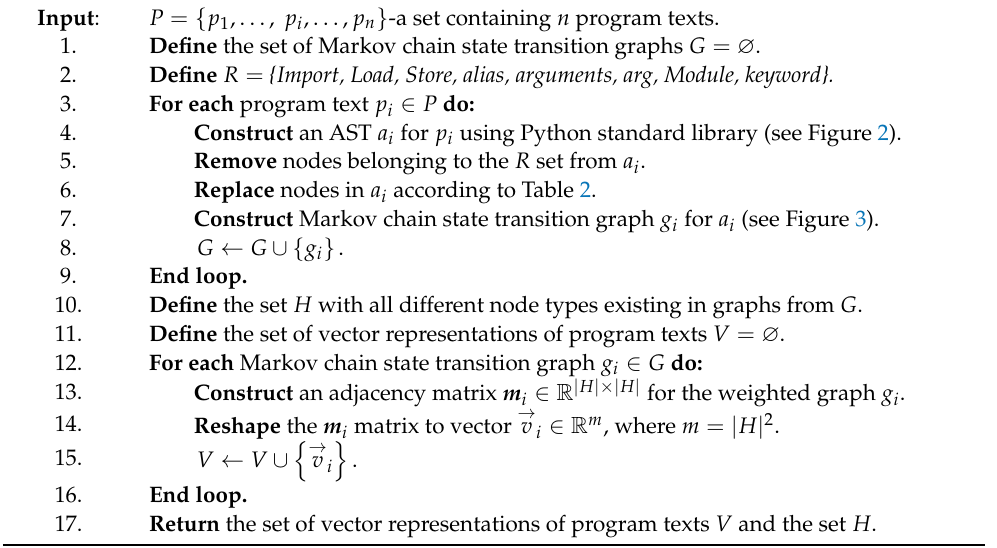
Algorithm 1 Vectorization of a set of program texts based on Markov chains.